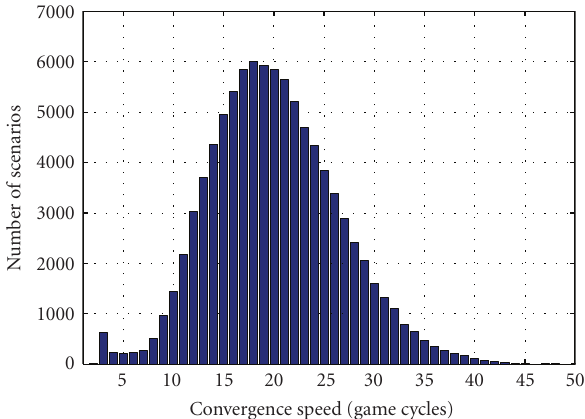
Figure 3: Convergence speed distribution for a 100-processor platform with w syn = 1 and w temp = 0: the average speed is 18 game cycles.